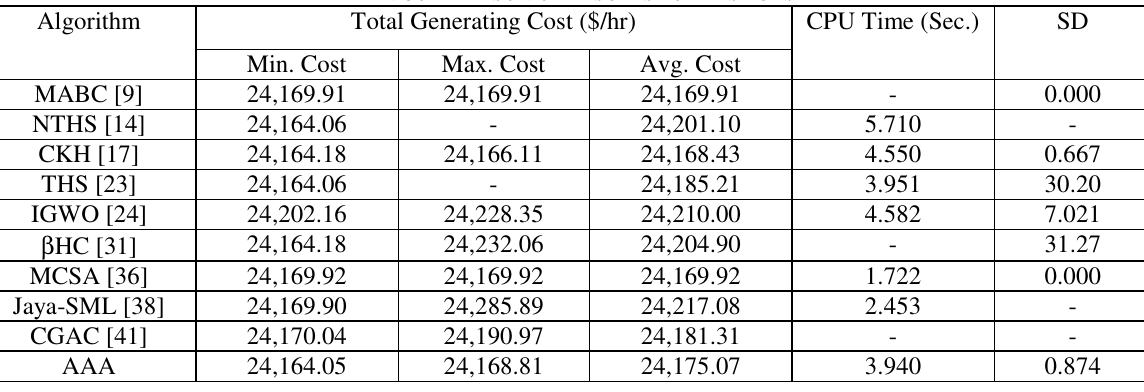
TABLE 4: COMPARISON OF RESULTS FOR TEST CASE